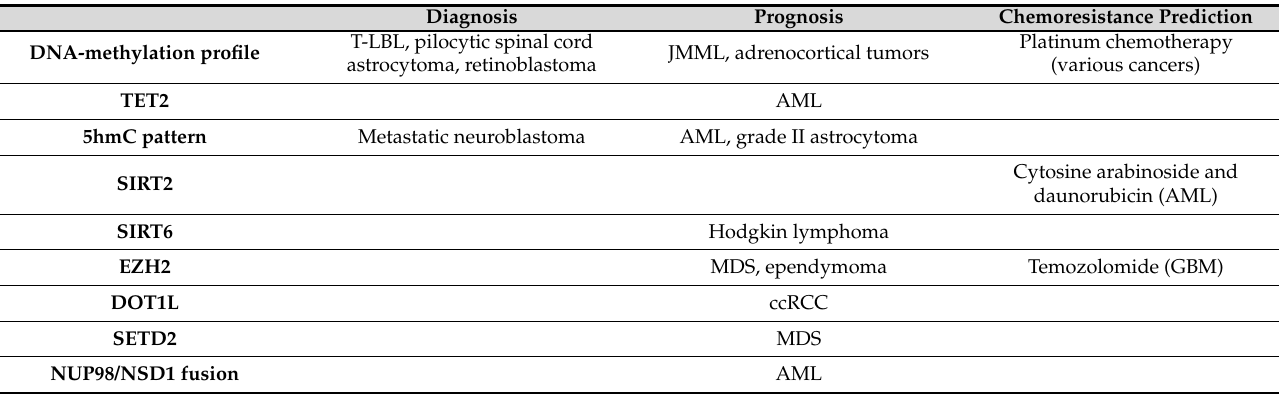
Figure 1. Epigenetic agents in the landscape of personalized anticancer treatment. Table 1. Examples for epigenetic biomarkers in the differential diagnosis, prognosis and chemoresistance prediction of malignant diseases (see references in the text). Diagnosis